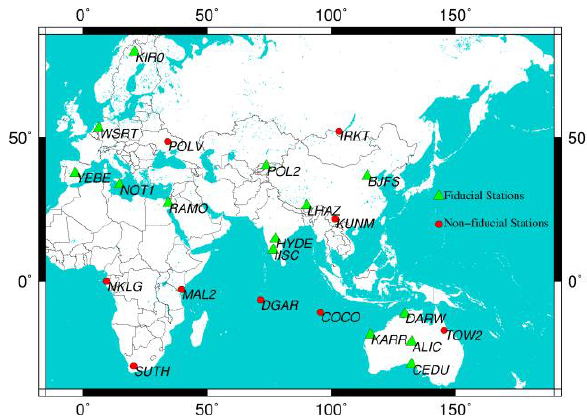
Figure 2. Fiducial and non-fiducial IGS stations selected for Bernese processing